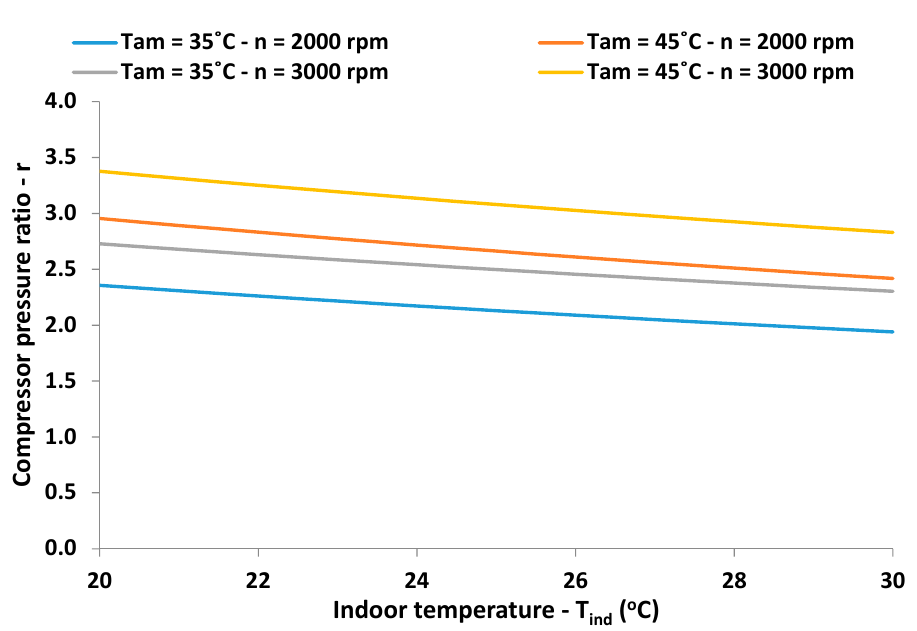
Figure 11. Cooling capacity for different indoor temperatures. Appl. Sci. 2018 , 8 , x FOR PEER REVIEW